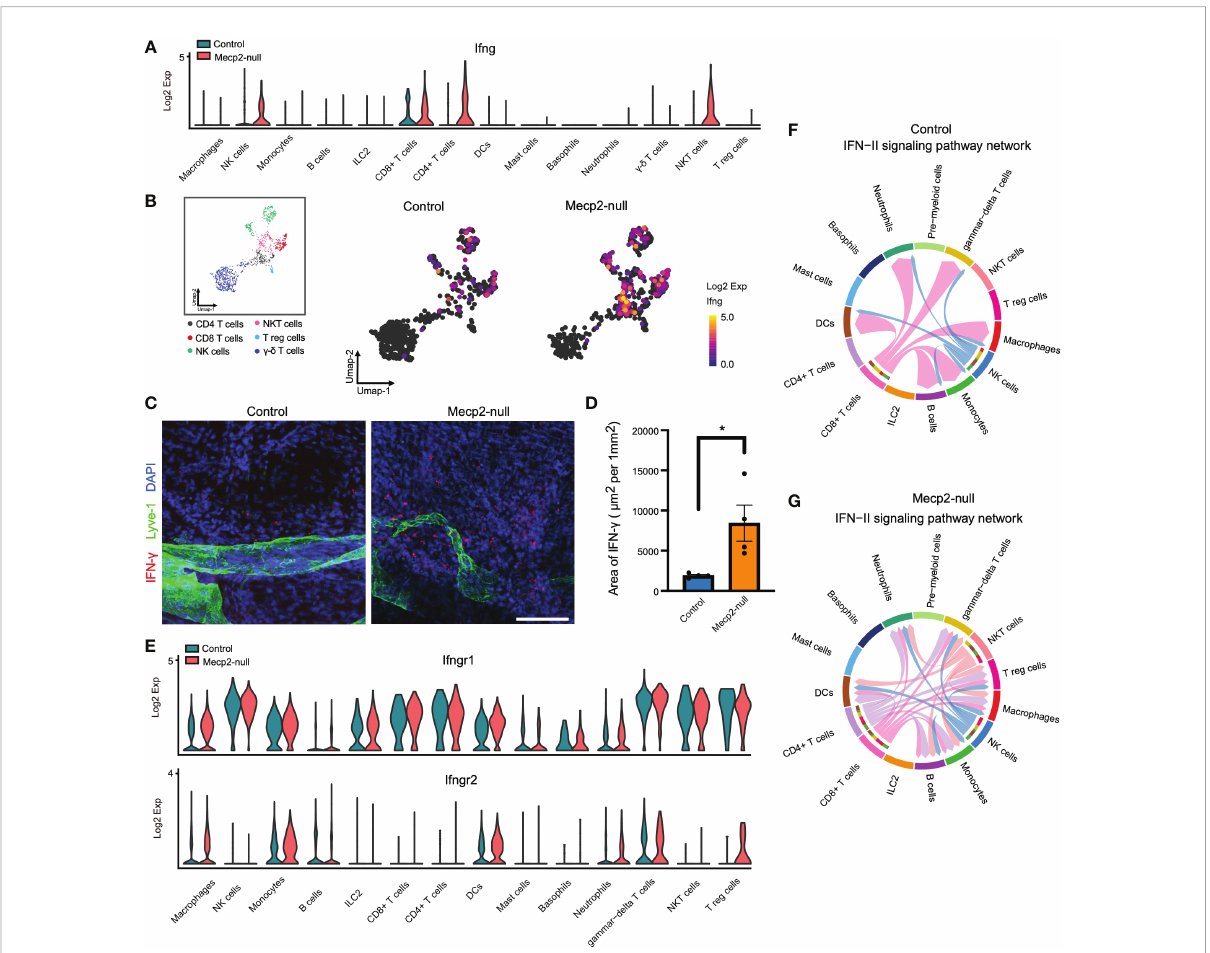
FIGURE 5 scRNA-seq analysis of IFN-II signaling pathway upregulation in multiple Mecp2-de fi cient cell populations. (A) Violin plots showing Ifng expression in different meningeal immune cells from control and Mecp2 -null mice. (B) Umap plots depicting Ifng expression in the main producer cells. (C) Representative confocal images of IFN- g (red) with lymphatic vessel endothelial receptor 1 (Lyve-1, Green) in the dura maters of control and Mecp2 -null mice. Scale bars: 100 m m. (D) Quanti fi cation of the area of IFN- g in the dura maters of control and Mecp2 -null mice (n=4 per group). Data represent the mean ± SEM. *p < 0.05, P = 0.0278, two-tailed unpaired t test. (E) Violin plots showing the expression of IFN- g receptors (Ifngr1 and Ifngr2) in different meningeal immune cells in control and Mecp2 -null mice. (F) Chord diagram visualizing cell-cell communication for the IFN-II signaling pathway in WT mice. (G) Chord diagram visualizing the cell-cell communication for IFN-II signaling pathway in Mecp2 -null